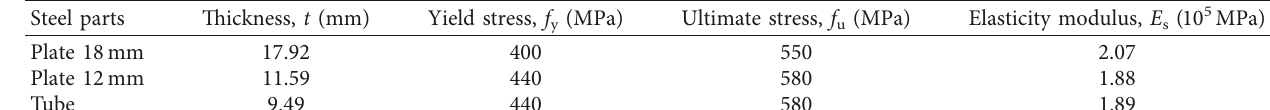
Table 2: Mechanical properties of the steel tube and gusset plate.